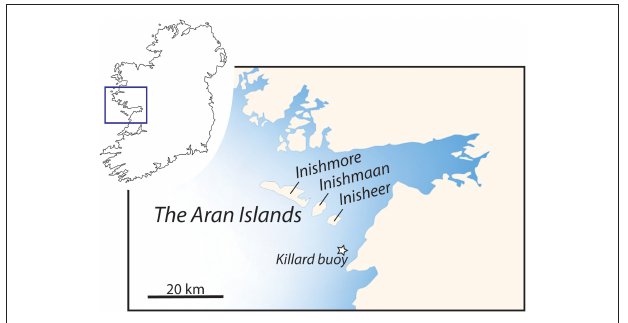
FIGURE 2 | Location of the Aran Islands, off the west coast of Ireland. Map base © maproom.net. Coastal boulder deposits ( Figure 1 ) occur along the Atlantic-facing coasts of all three